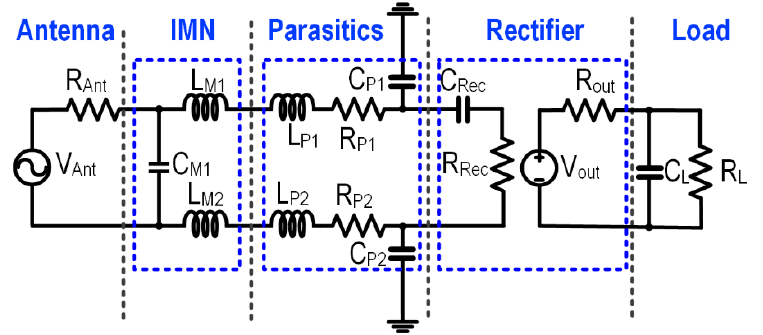
Figure 4. Equivalent circuit of the RFEH front-end.